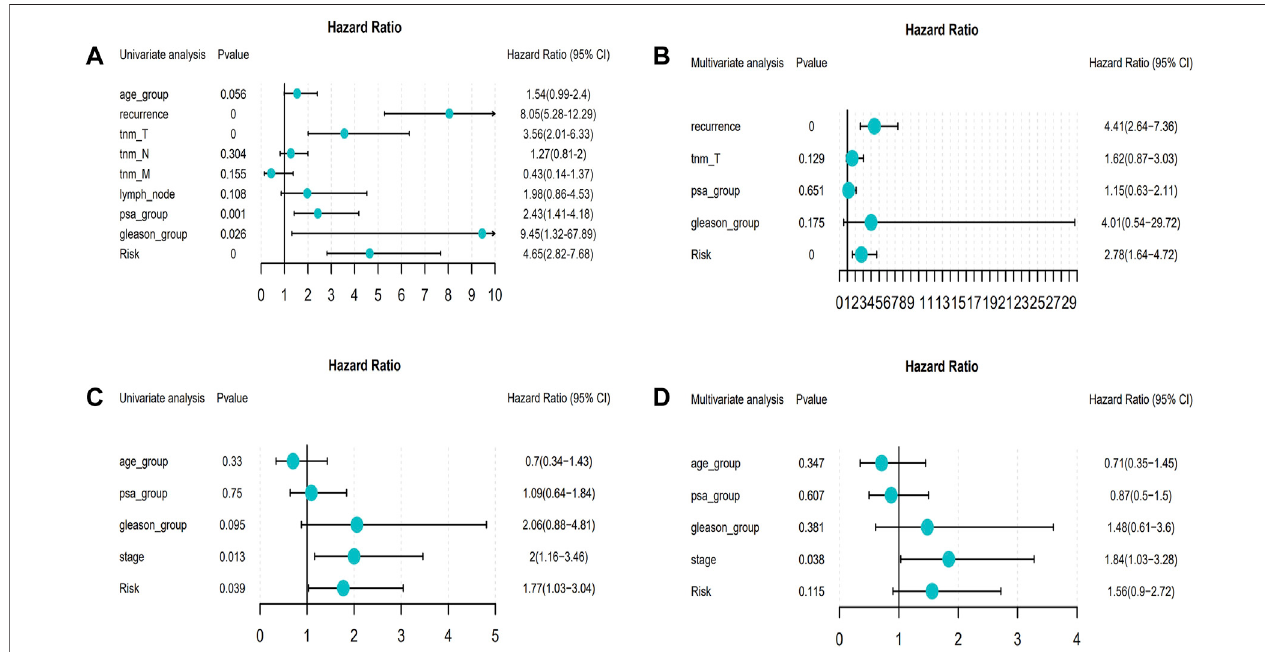
FIGURE 6 | Forest map about the relationship between risk model and clinical characteristics (From left to right: Column 1: Clinical features; Column 2: p value; Column 3: Hazard Ratio forest map; Column 4: hazard ratio (HR) analysis with 95% con fi dence intervals (CI).). (A) Univariate Cox of model risk and eight clinical characteristics(age,recurrence,tnm_T,tnm_N,tnm_M,lymph_node,PSA,andGleason)inthetrainingcohort; (B) MultivariateCoxofrecurrence,tnm_T,PSA,Gleason, and model risk in training cohort; (C) Univariate Cox of model risk and four clinical characteristics (Age, PSA, Gleason, and Stage) in the validation cohort; (D) Multivariate Cox of model risk and four clinical phenotypes (Age, PSA, Gleason, and Stage) in validation